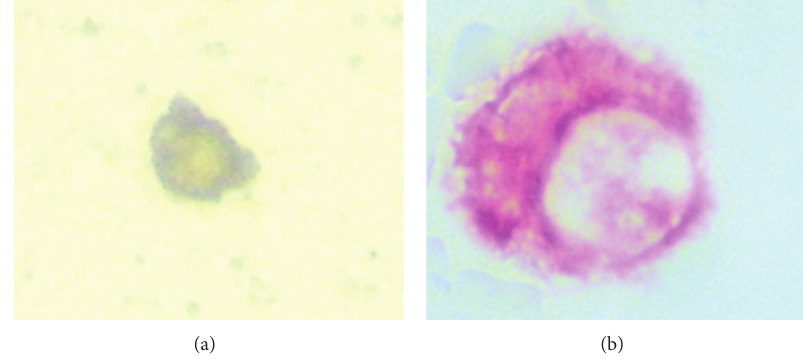
Figure 1: (a) Leucocyte (PSA negative). (b) CPC PSA positive.